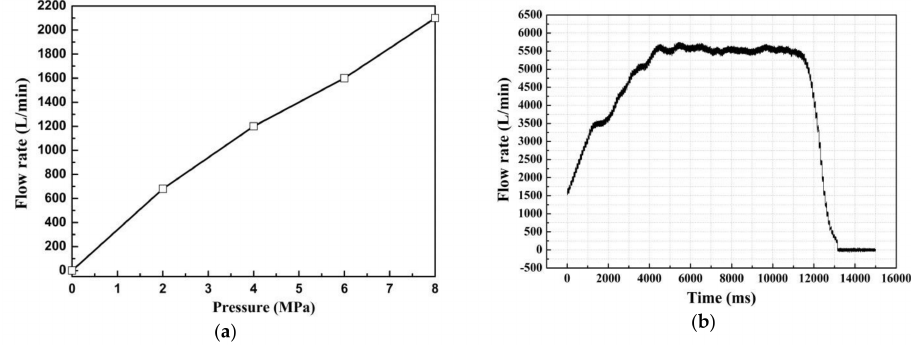
Figure 11. Flow curve of VCM-DHPV under different supply pressures: ( a ) VCM-DHPV prototype; and ( b ) maximum flow